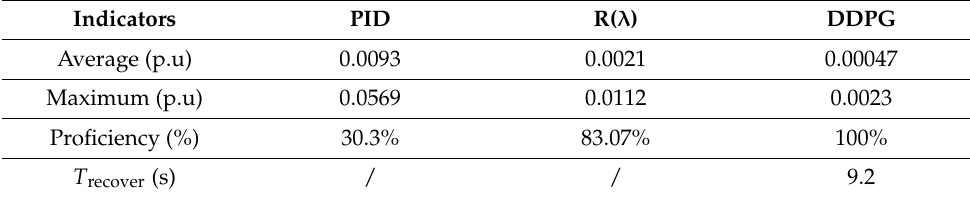
Table 6. Voltage simulation results under load disturbance.